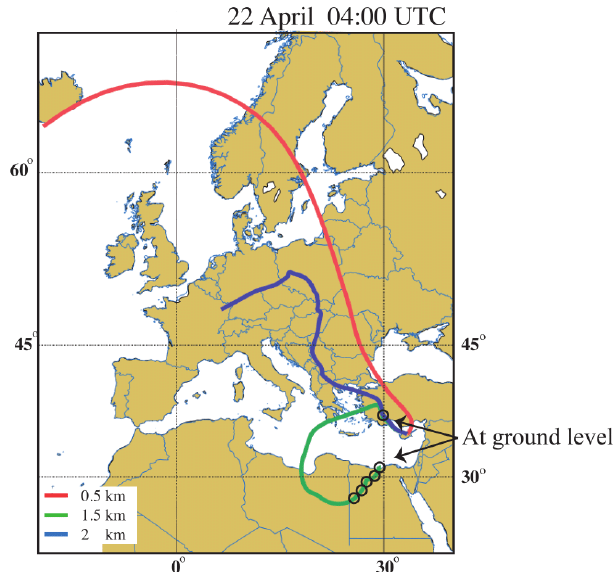
Figure 9. Back-trajectories of the air masses arriving at 500, 1000 and 1500m over Cyprus at 04:00UTC on 22 April. The back- trajectories were calculated for a duration of 6 days. The black cir- cles indicate the locations where the air mass was below 100m al-